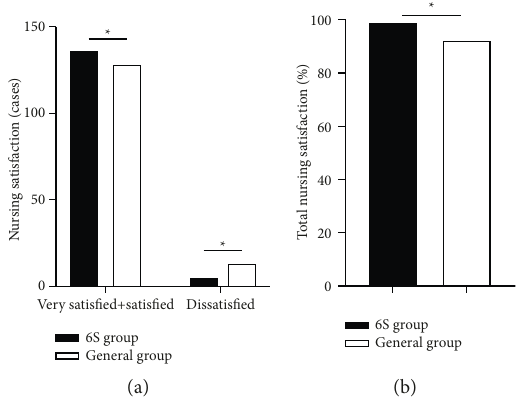
Figure 6: Analysis of patient satisfaction with care in both groups. (a) Satisfaction score (scores). (b) Total nursing satisfaction (%). The 6S group compared to the general group, ∗ P > 0 .